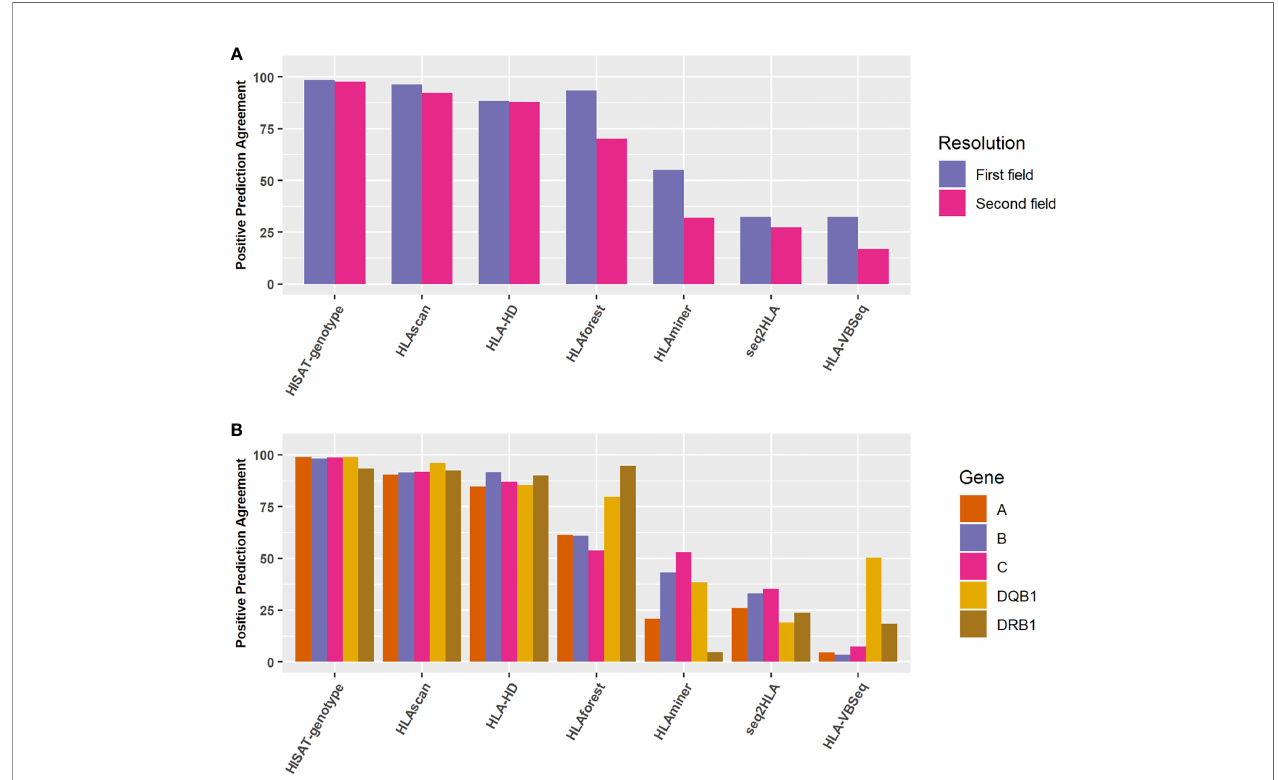
FIGURE 6 | Positive prediction agreement of the seven algorithms for HLA typing at different resolutions and genes. (A) Agreement for the seven algorithms at the fi rst fi eld or the second fi eld levels. (B) Agreement for the seven algorithms for different HLA genes at the second fi eld